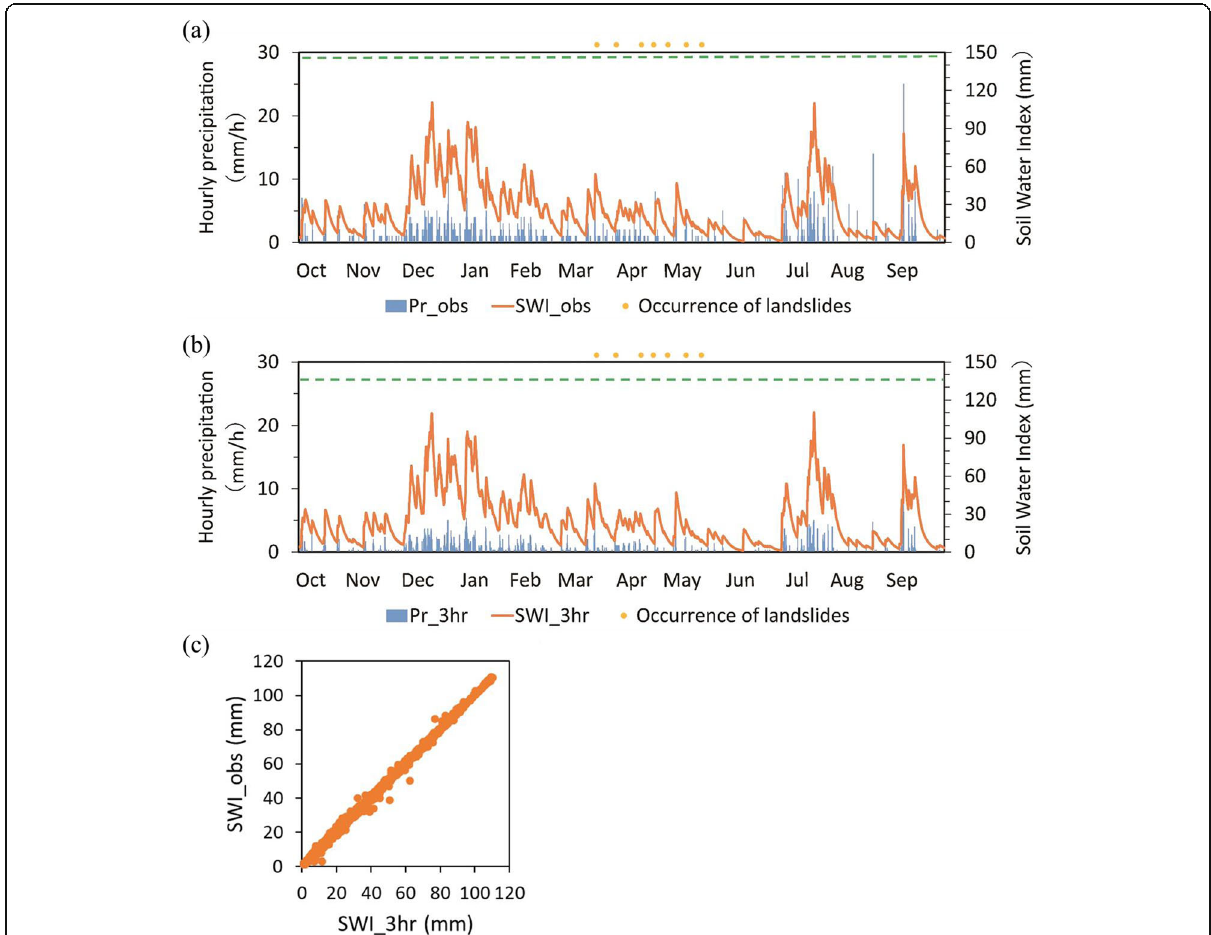
Fig. 4 a Original SWI (orange line) calculated by observed hourly precipitation (blue bars) at AMeDAS Sekiyama (Fig. 2c) from October 1, 2005, to September 30, 2006. Yellow dots represent the occurrences of snowmelt-driven landslide disasters. The maximum SWI (143 mm) of the past 10 years (1995 – 2004) is depicted by the green dashed line. In this figure, snowfall-accumulation-snowmelt processes are not implemented. b Same as a but the hourly precipitation is given as the average of three-hourly accumulated precipitation. In this case, the maximum SWI of the past 10 years is 135 mm. c Scatter diagram between SWI_3hr ( b ) and SWI_obs ( a ), with the correlation coefficient being nearly equal to